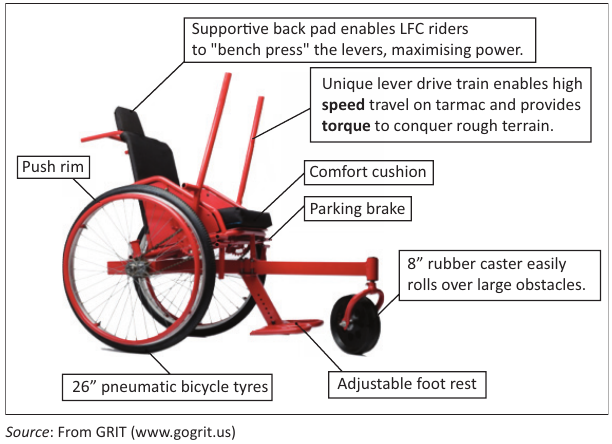
FIGURE 3: Leveraged Freedom Chair.